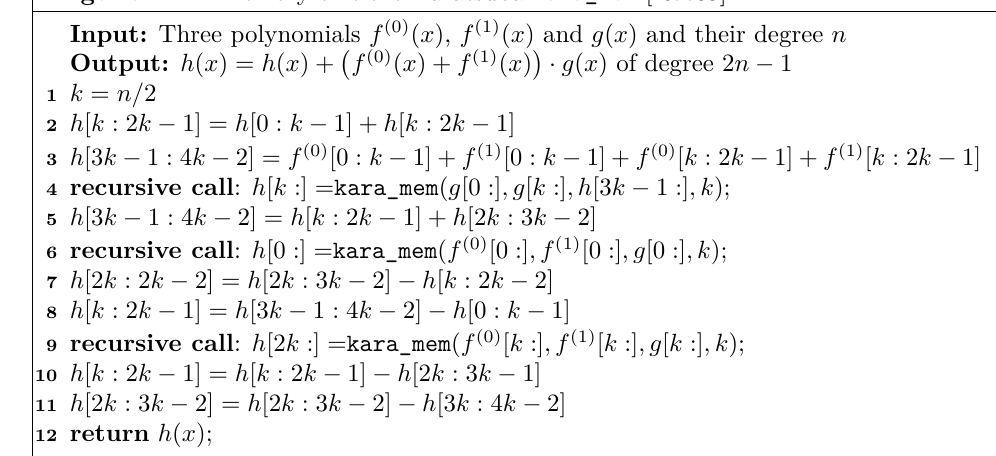
Algorithm 4: Memory efficient Karatsuba kara_mem